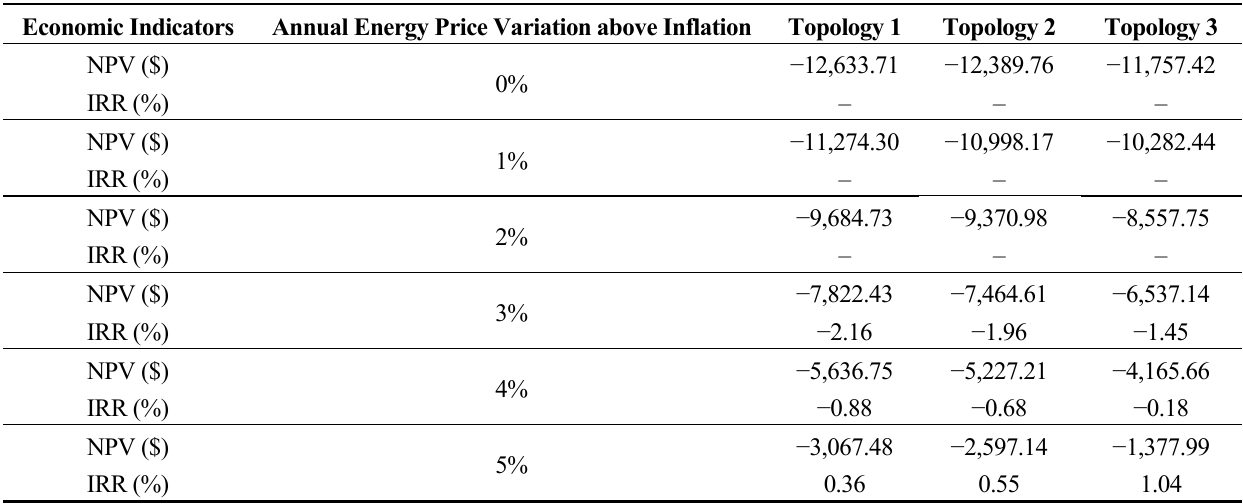
Table 11. Effect of variation in the annual increase in energy prices above inflation. Economic